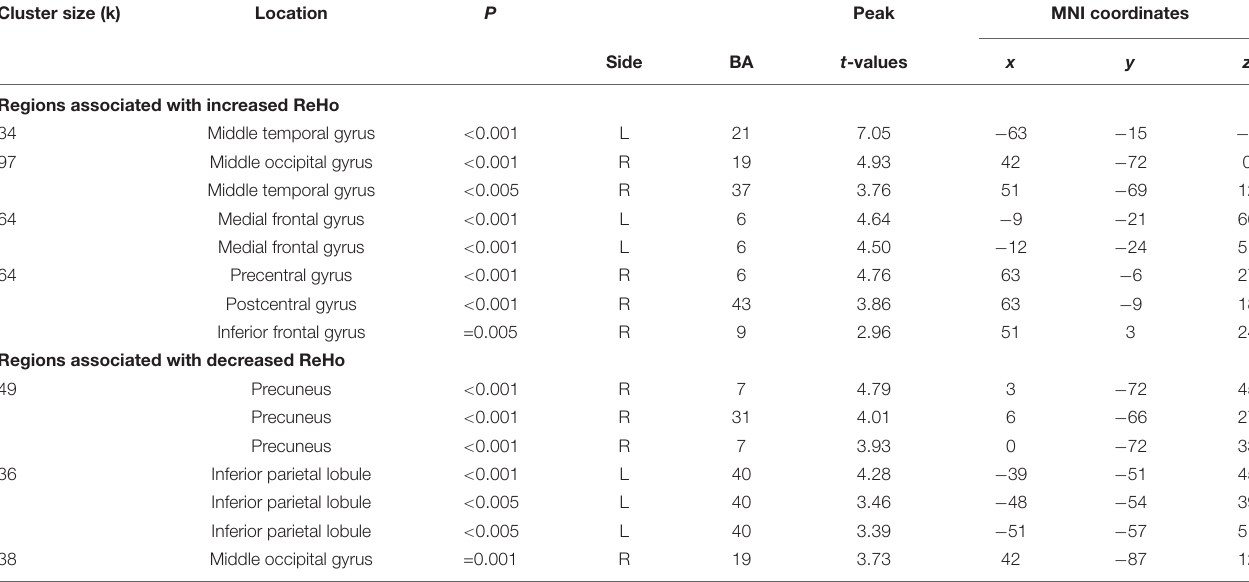
FIGURE 1 | Coronal and axial multislice views of regions with significant group differences in ReHo values. Color code; red, regions for which the NM group exhibited lower ReHo values than did controls; blue, regions for which the NM group exhibited higher ReHo values than did controls. Significant regions were obtained with the following combination of statistical thresholds: p < 0.01 at voxel level within clusters > 26. TABLE 3 | Localization of regions showing correlations between NDQ scores and ReHo values in NM group. Cluster size